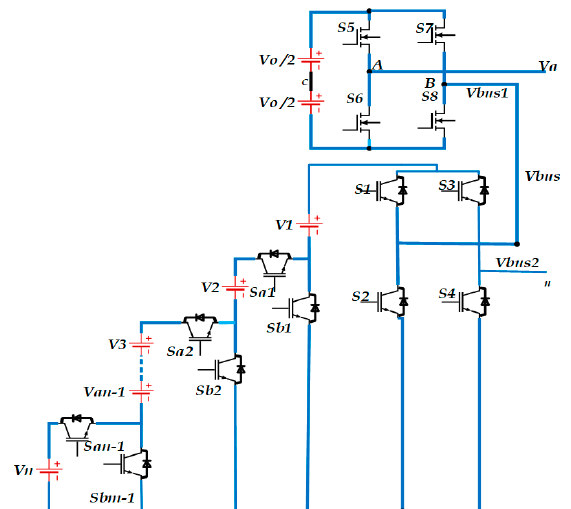
Figure 10. 15 − Level MLI.